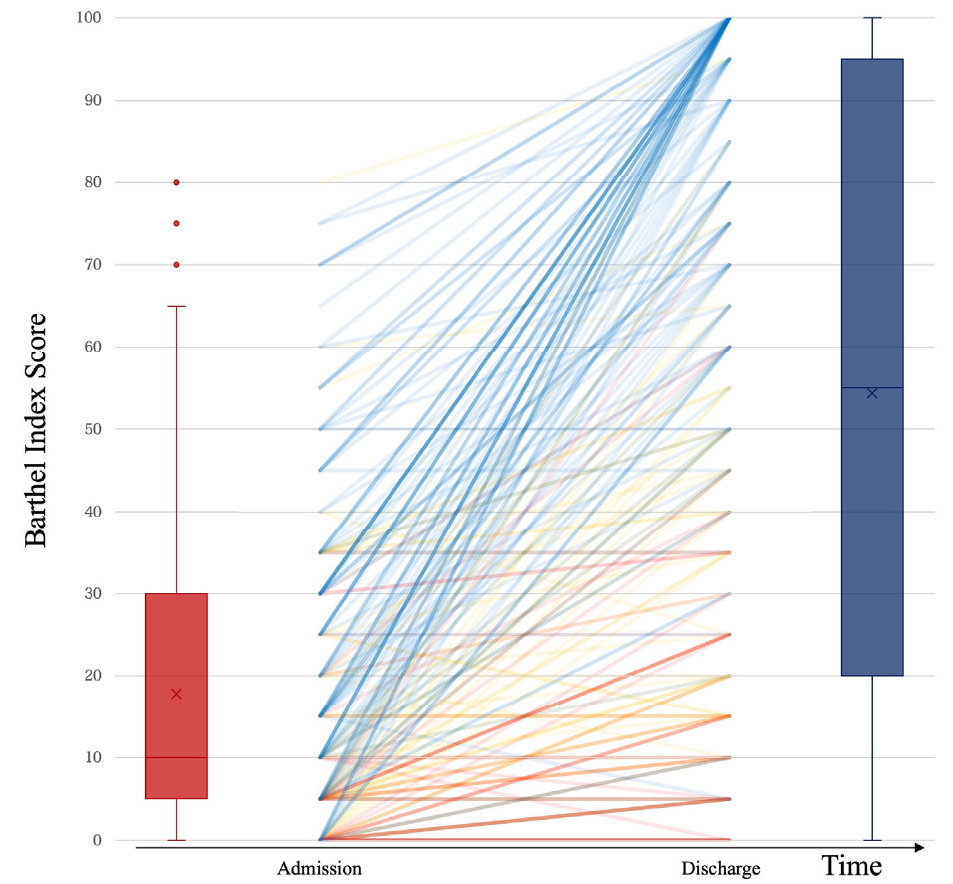
Figure 1. The effect of dementia on ADL changes during hospitalization. ADL is presented using the Barthel Index score (BI: 0–100 points), while the color of the line denotes dementia status: red line, severe dementia ( n = 47); yellow line, moderate dementia ( n = 78); and blue line, no cognitive impairment ( n = 136). Overlapping lines are presented in mixed or overlapping (darker) colors. The red box plot shows BI score on admission, and the blue box plot shows BI score on discharge.